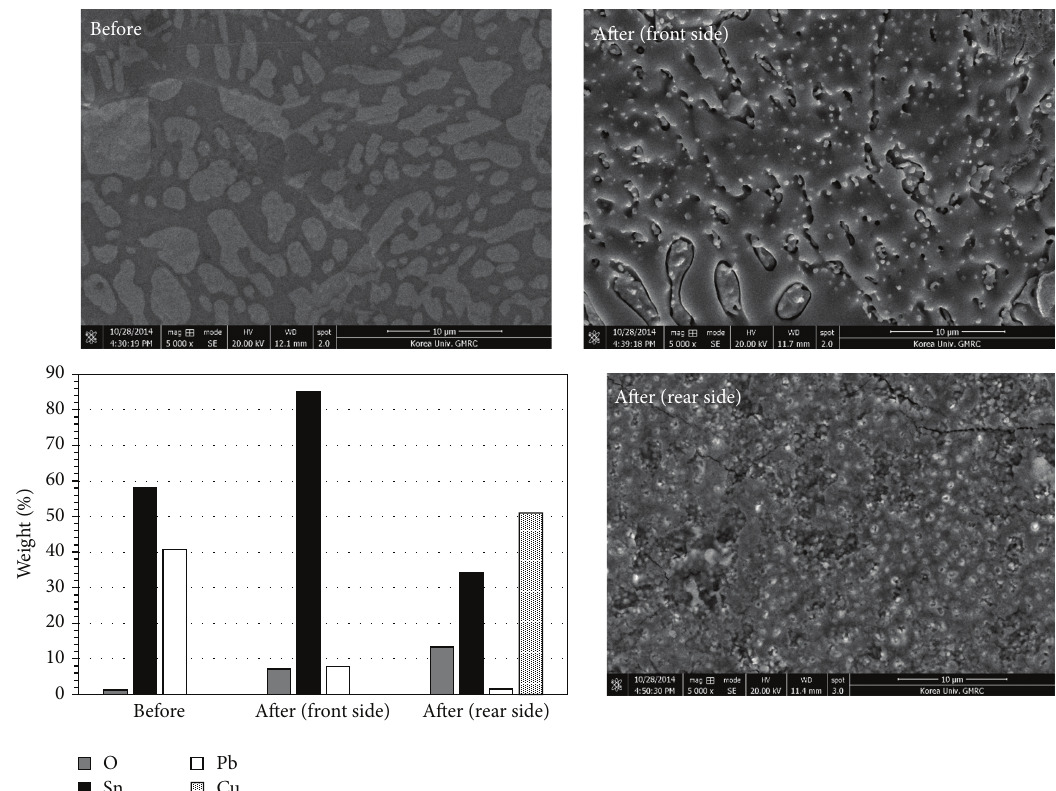
Figure 7: SEM images and EDS analysis on surface of SnPb before/after